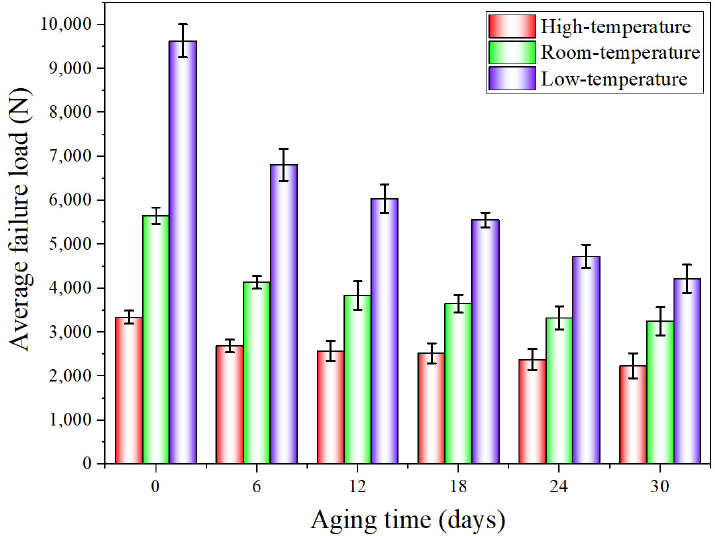
Figure 8. The average failure load of TASJs after hygrothermal aging at different temperatures.